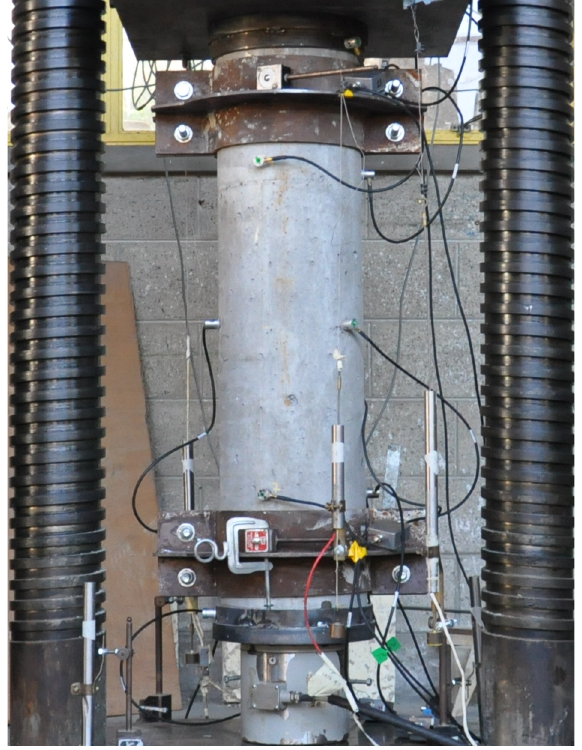
Figure 2. Test set-up of the reinforced concrete column